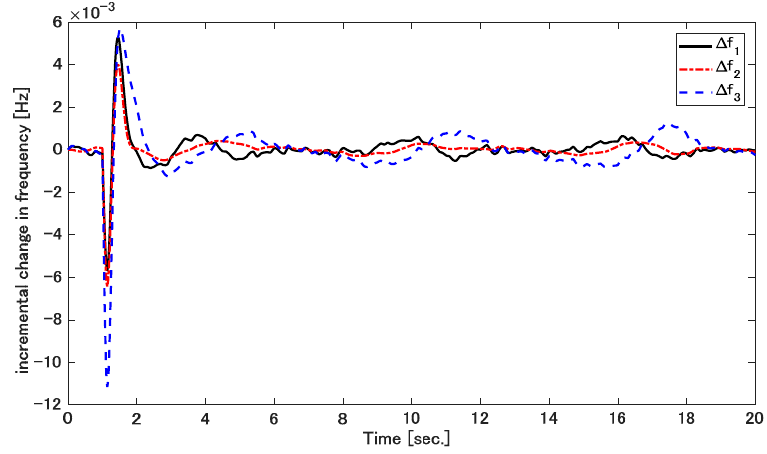
Figure 13. Frequency deviation of three-area power system with a wind plant.